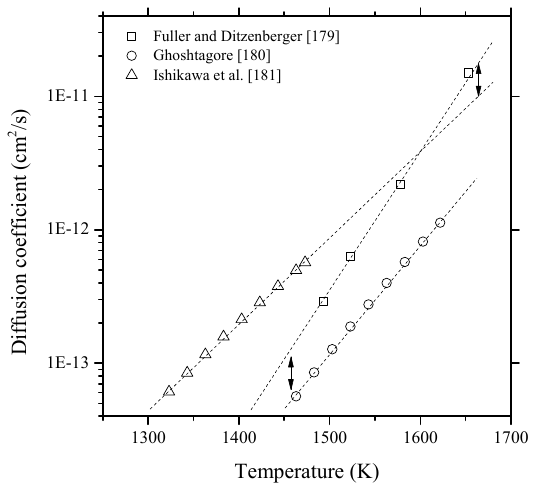
Figure 16. The temperature dependence of the diffusion coefficients, D Bi , in silicon; □ : [179]; ○ : [180]; Δ : [181].